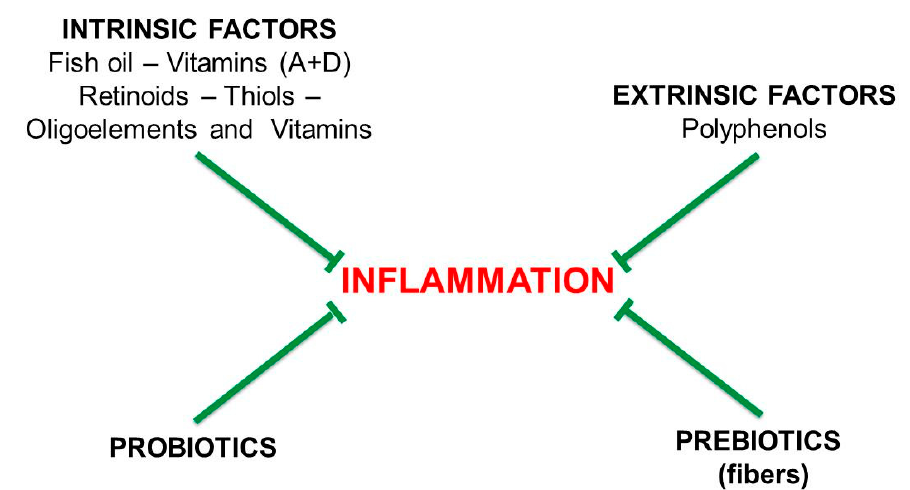
Figure 4. Anti-inflammatory dietary factors. The intrinsic factors are those playing a role in our